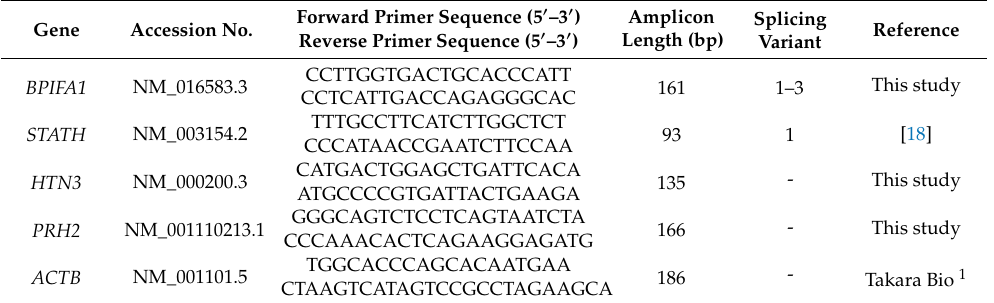
Table 1. Primers for nasal secretion and saliva characteristic target genes and the reference